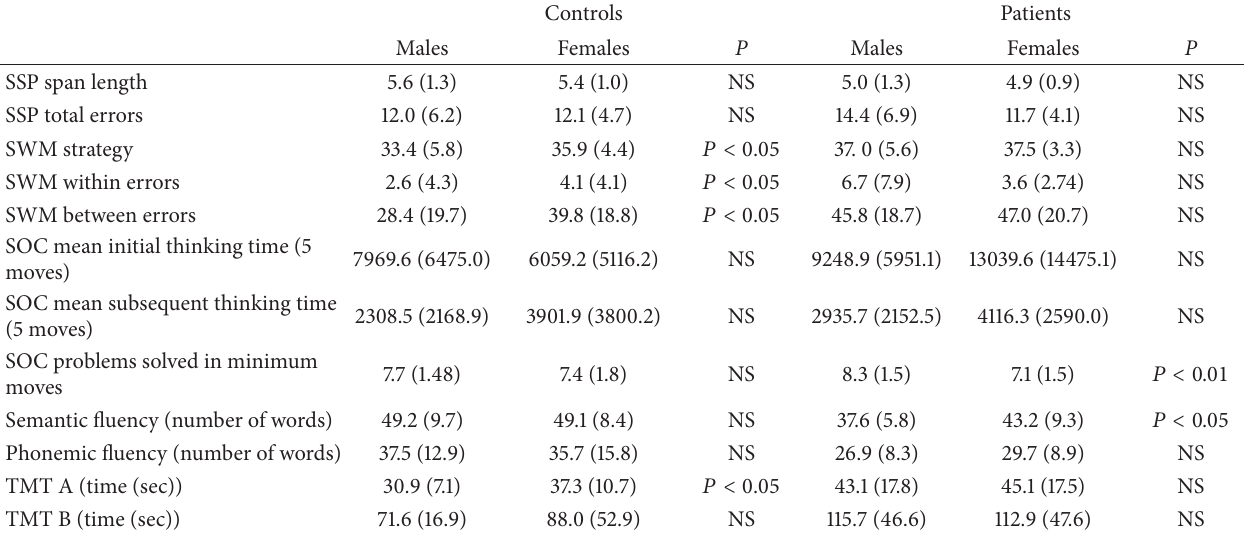
Table 3: Within-group comparisons of cognitive functions (values expressed as means and standard deviations shown in